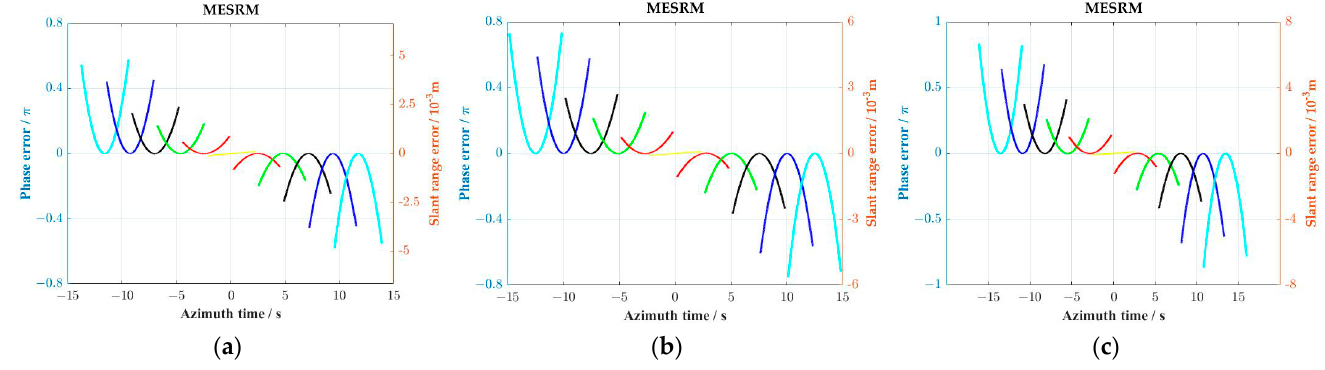
Figure 3. The slant range error and phase error as a function of azimuth time caused by MESRM. ( a – c ) represent the errors along azimuth direction in the near, central, and far range cells, respectively. Lines with different colors represent the errors of different targets with a constant interval of 2 km along azimuth direction.